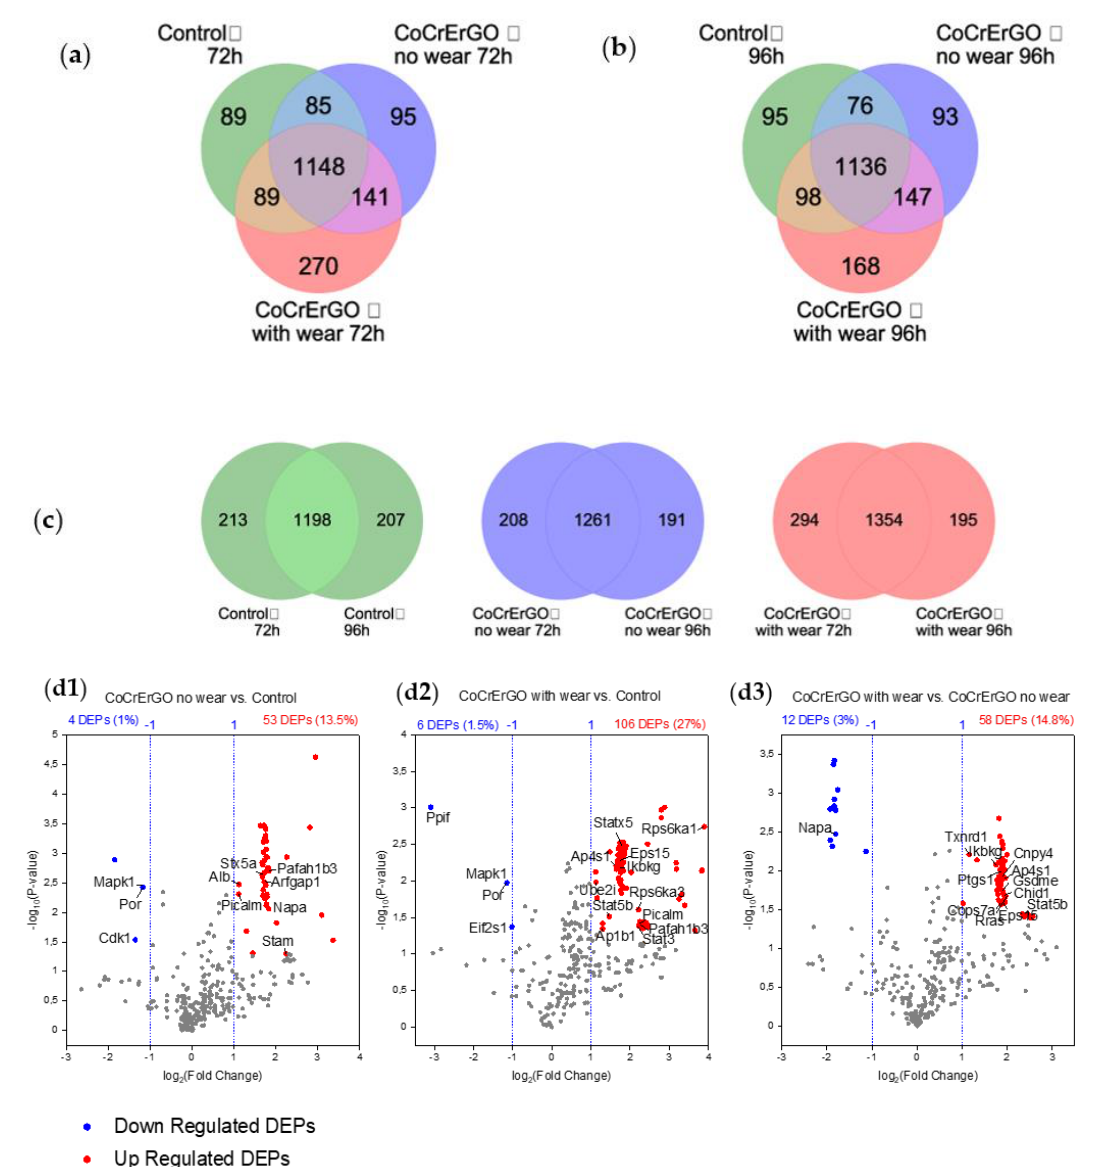
Figure 3. Proteomic profiling of J744A.1 macrophages in response to CoCrErGO surfaces: ( a , b ) Inter-group Venn diagrams showing the total number of proteins identified in macrophage proteome exclusively expressed in a group or shared between groups, after 72 h and 96 h of biomaterial interaction; ( c ) Intra-group Venn diagrams showing the total number of proteins identified in macrophage proteome in each group, exclusively expressed after 72 h or 96 h or shared expression at both times of exposure; ( d ) Pairwise volcano plots ( d1 – d3 ) showing differentially expressed proteins (DEPs) between pairwise group comparisons: CoCrErGO no wear vs. control ( d1 ) CoCrErGO with wear vs. control ( d2 ), CoCrErGO with wear vs. CoCrErGO no wear ( d3 ); Statistically significant DEPs were computed by Student’s t-test pairwise comparisons with a p -value < 0.05.